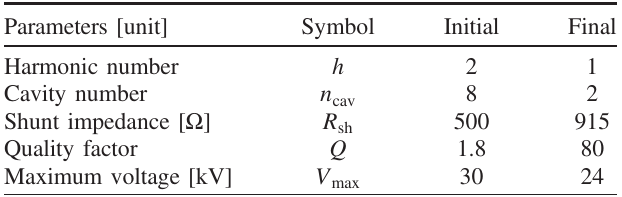
TABLE I. Main parameters of the RLC model for the initial and the final rf system for the bunch merging in the CSNS-II/RCS [34].